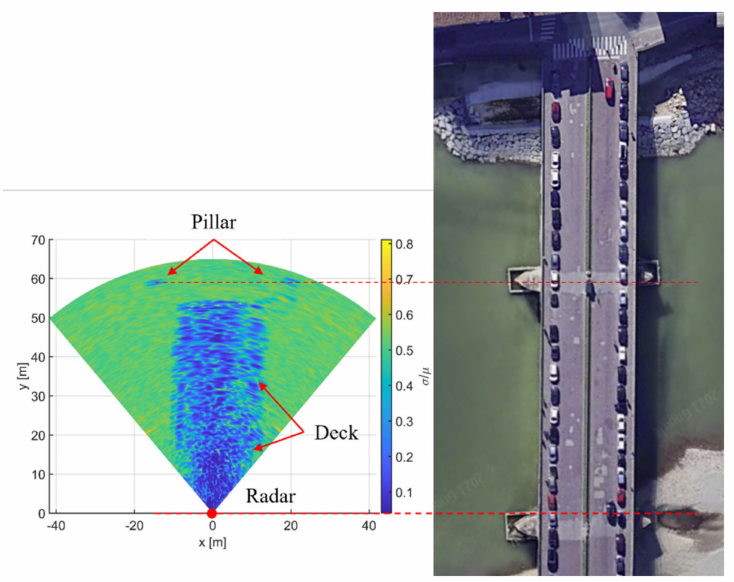
Figure 16. Index of dispersion of radar images of Vespucci bridge focused on the horizontal plane at z = 6.5